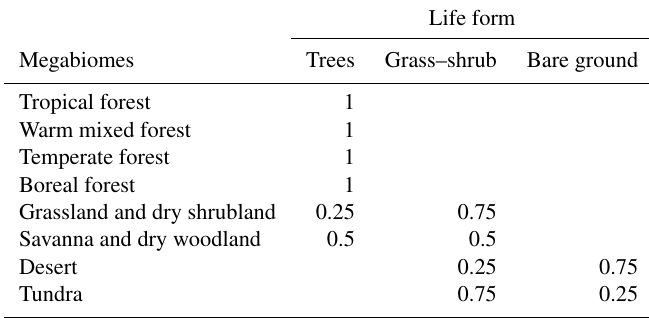
Table 4. Important values for each plant life form used in the (cid:49)V statistical calculation as assigned to the megabiomes.